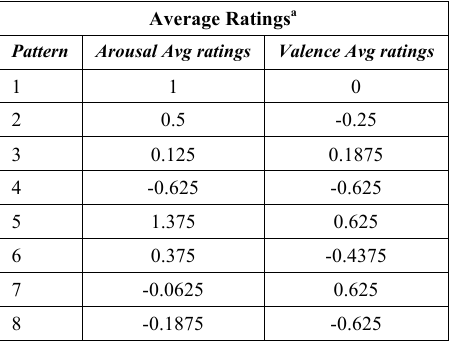
A ROUSAL AND V ALENCE A VERAGE R